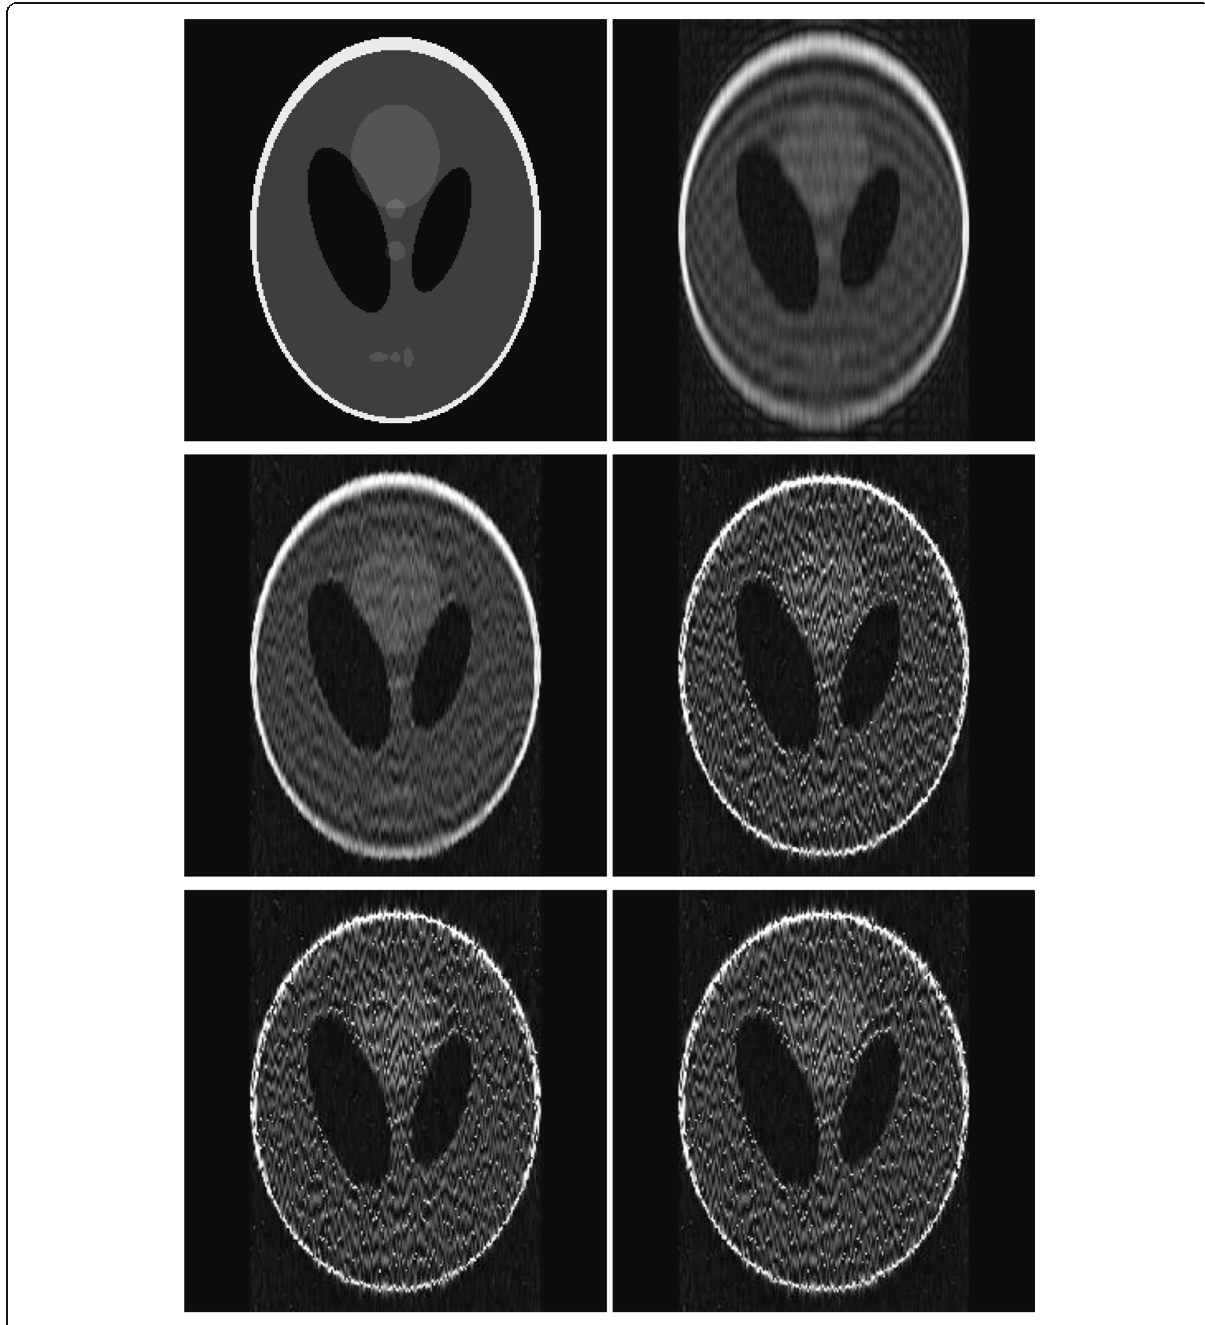
Fig. 4 Reconstruction of the Shepp-Logan phantom with noisy data. Row 1: (L) the true phantom; (R) the result with the initial condition. Row 2: (L) the result with 10 2 iterations; (R) the result with 10 4 iterations. Row 3: (L) the result with 10 6 iterations; (R) the result with 10 8